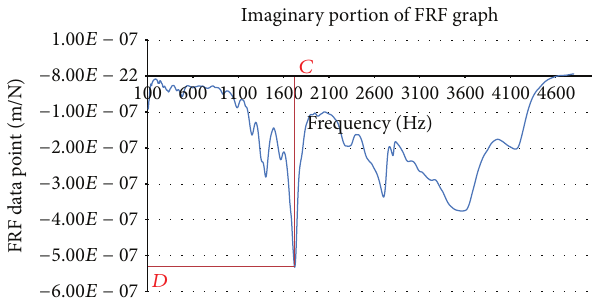
Figure 6: Spindle experimental frequency response function (FRF) (imaginary